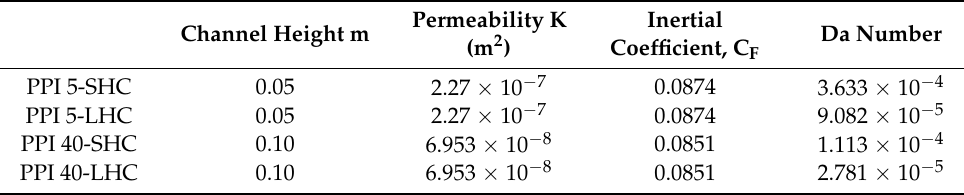
Table 1. Abbreviation for presentation of the results and the values of volume average transport parameters of metal